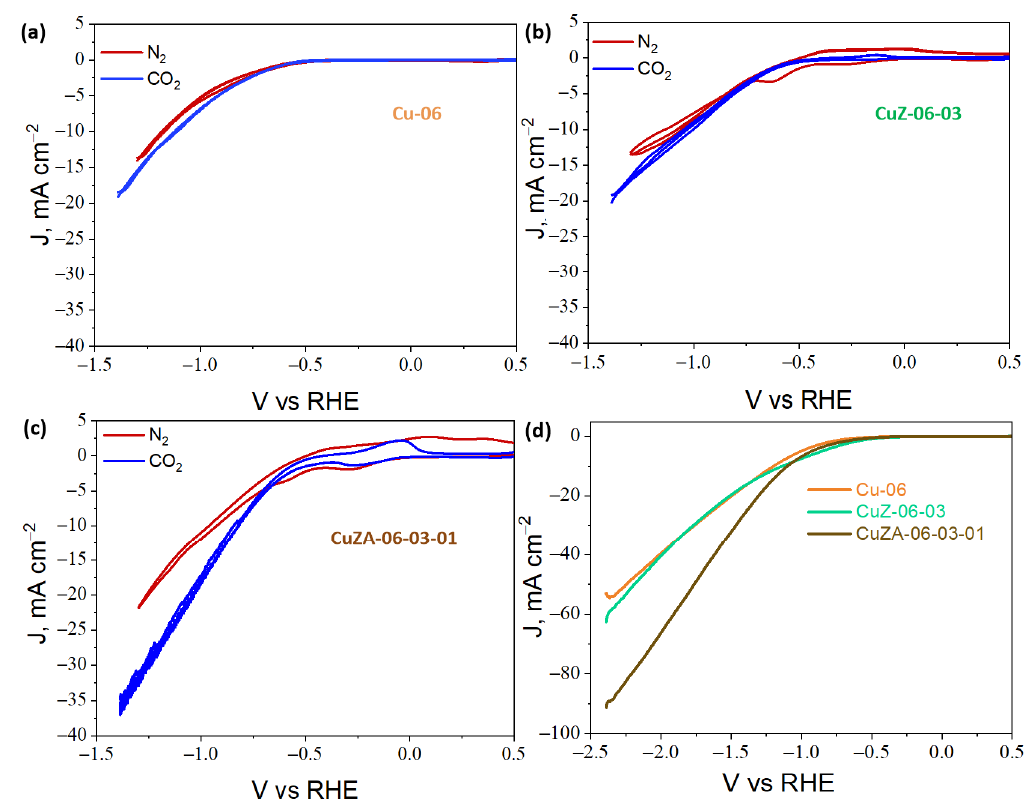
Figure 10. Cyclic voltammetry responses for ( a ) Cu-06, ( b ) CuZ-06-03, ( c ) and CuZA-06-03-01 electrodes in a CO 2 and N 2 saturated 0.1 M KHCO 3 aqueous solution. Linear polarization curves obtained for the CuZnAl-oxide based electrodes in the CO 2 -purged 0.1 M KHCO 3 electrolyte (scan rate: 5 mV s − 1 ) ( d ).